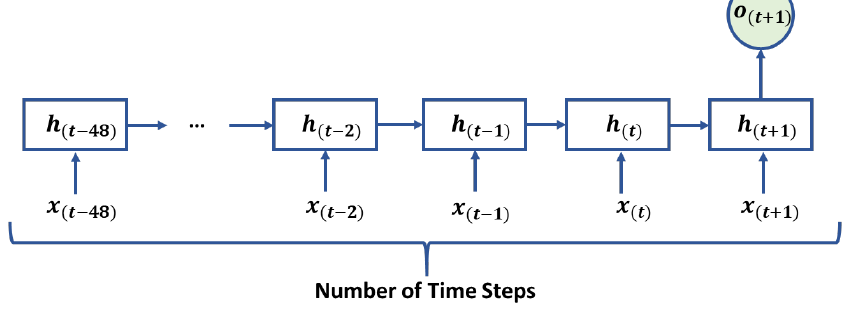
Figure 7. The Sequence Length of LSTM for Electricity Load